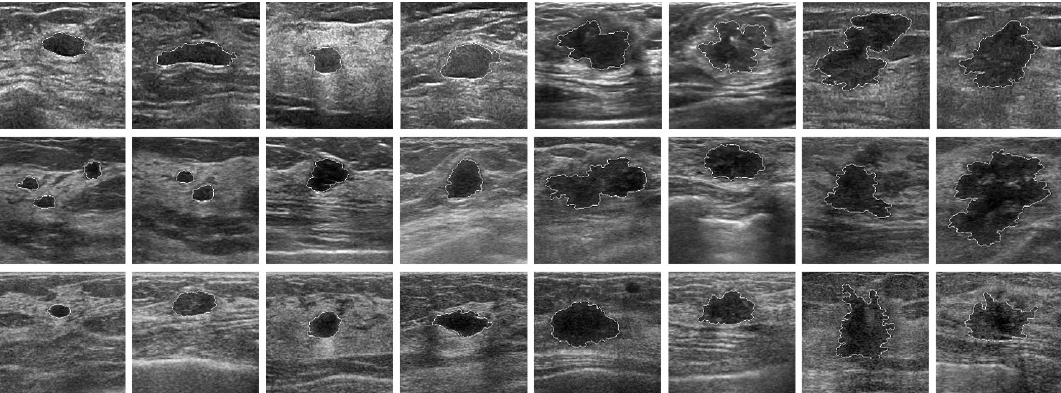
Figure 6. Resultant images after tumor contour detection with different machines. First row is the resultant images tested with Model B, second row is the resultant images tested with Model B images, and third row is resultant images tested with Model C; images in column one and two are results tested with BI-RADS 2 cases; images in column three and four are results tested with BI-RADS 3 cases, images in column five and six are results tested with BI-RADS 4 cases; images in column seven and eight are results tested with BI-RADS